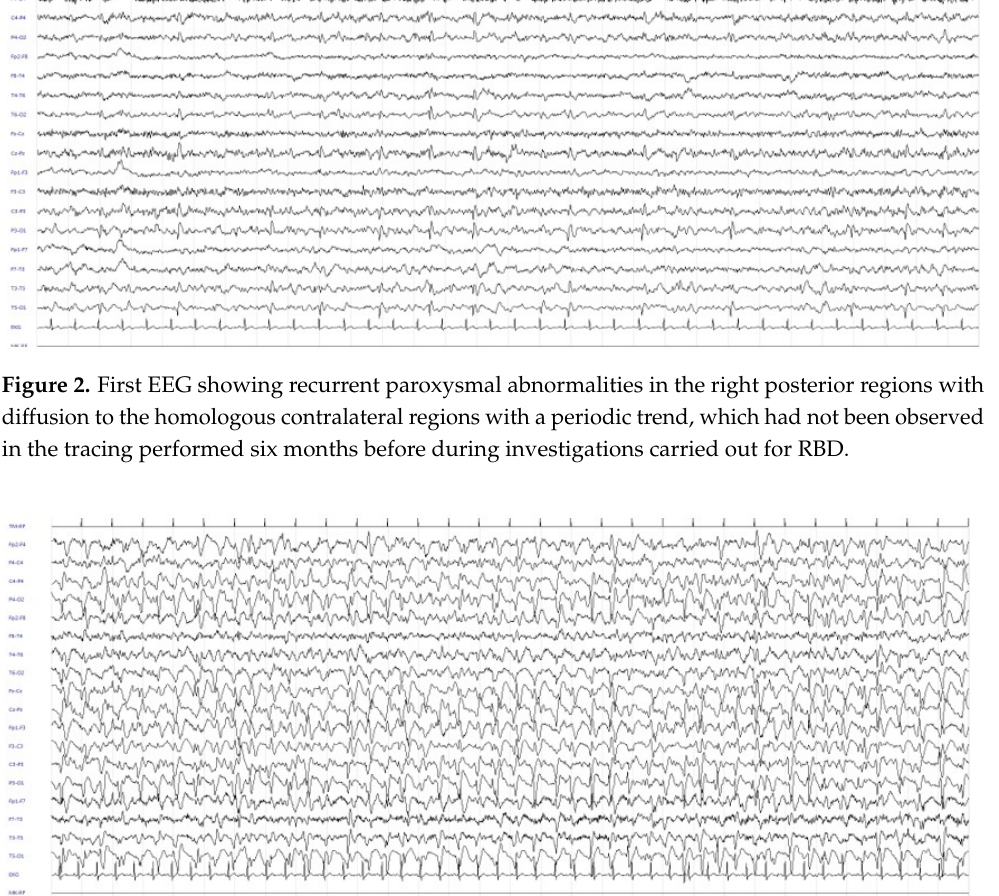
Figure 3. Recurrent paroxysmal diphasic and triphasic abnormalities in the right posterior regions with diffusion to the contralateral homologous regions, sometimes in a periodic pattern .